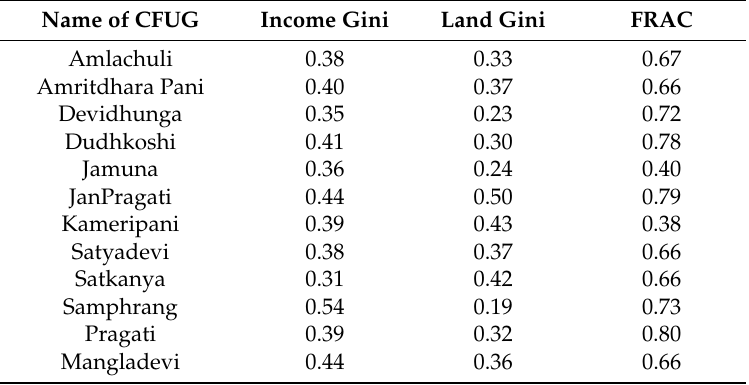
Table 6. Gini coefficients for income and land inequality and index of ethnic diversity (FRAC) for the study sites in